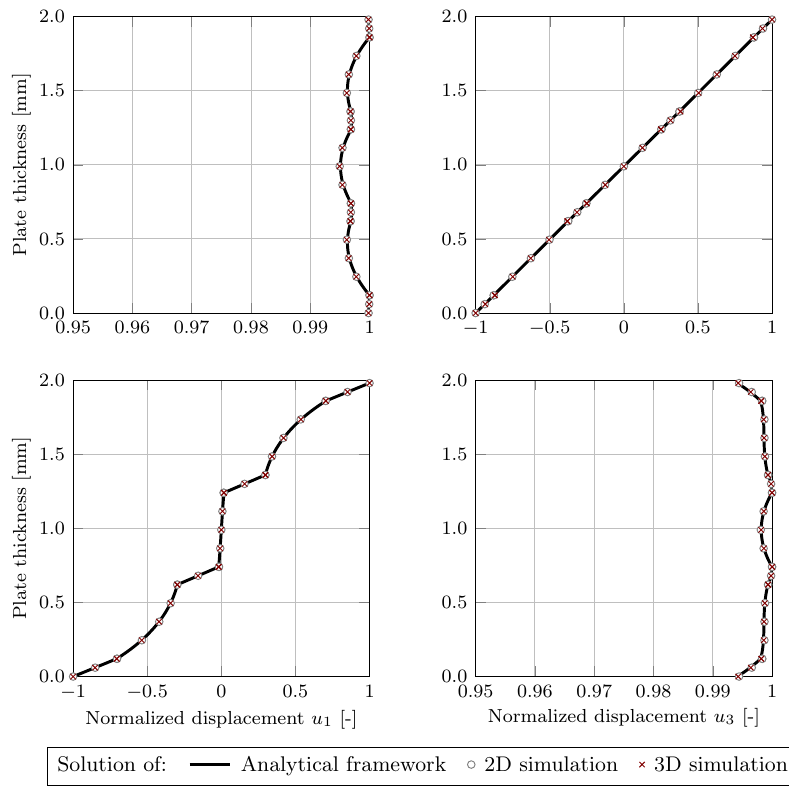
Figure A2. In-plane ( left ) and out-of-plane ( right ) components of a normalized displacement field for S 0 ( top ) and A 0 ( bottom ) wave modes in the fiber orientation at 80kHz derived from the analytical framework and numerical 2D- and